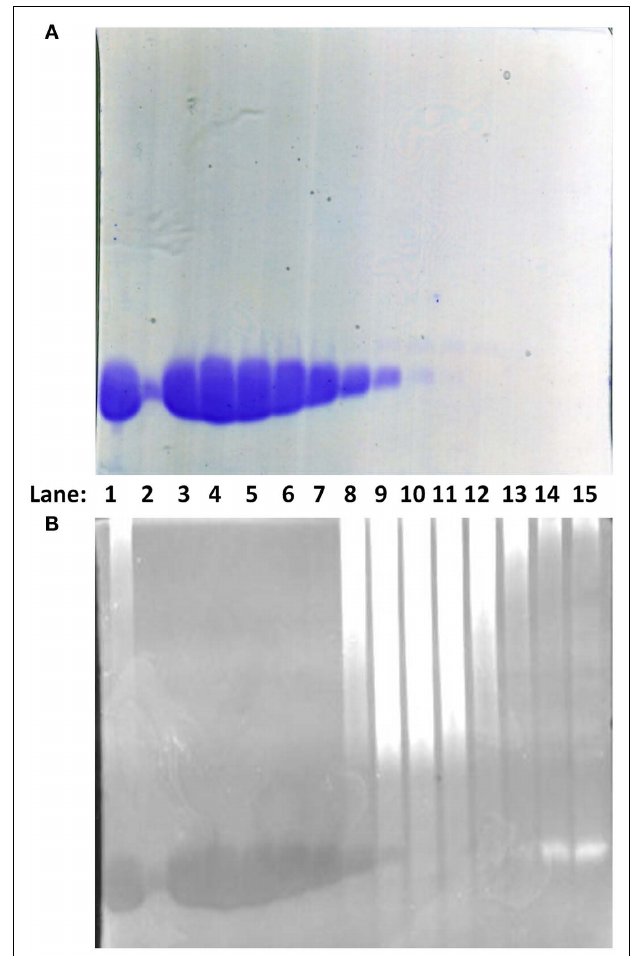
FIGURE 1 | Purification of PV. (A) SDS-PAGE analysis of the DEAE column purification profile for the E62D, F102W β -PV.The gel was stained with Coomassie Brilliant Blue. Lane 1: a positive control sample from rat F102W β -PV, which was characterized before the nucleic acid contamination issue was resolved. Lanes 2–15 correspond to elution fractions from 21 to 35 after the DEAE column (refer to Materials and Method). (B) the same SDS-PAGE from (A) , but was re-stained with Ethidium Bromide and viewed with UV light (refer to Materials and